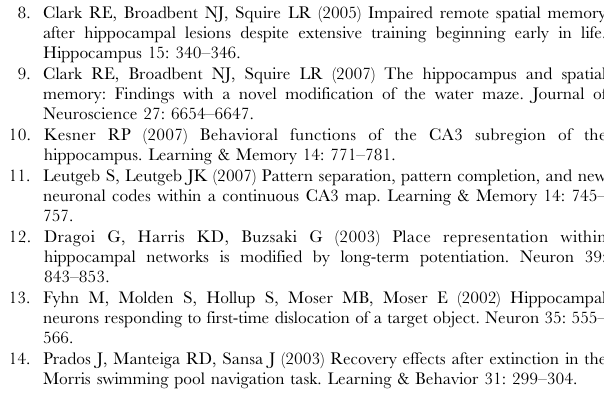
Figure S1 Time bin analysis of probe test performance. ( ABIJ ) Swim speed across 15-s time bins. ( CDKL ) Number of target crosses across 15-s time bins. ( EFMN ) Time spent in a 25- cm circular zone centered on the target location across 15-s time bins. ( GHOP ). Time spent in the target location quadrant across 15-s time bins. (TIF) Text S1 Results of time bin analysis of probe test